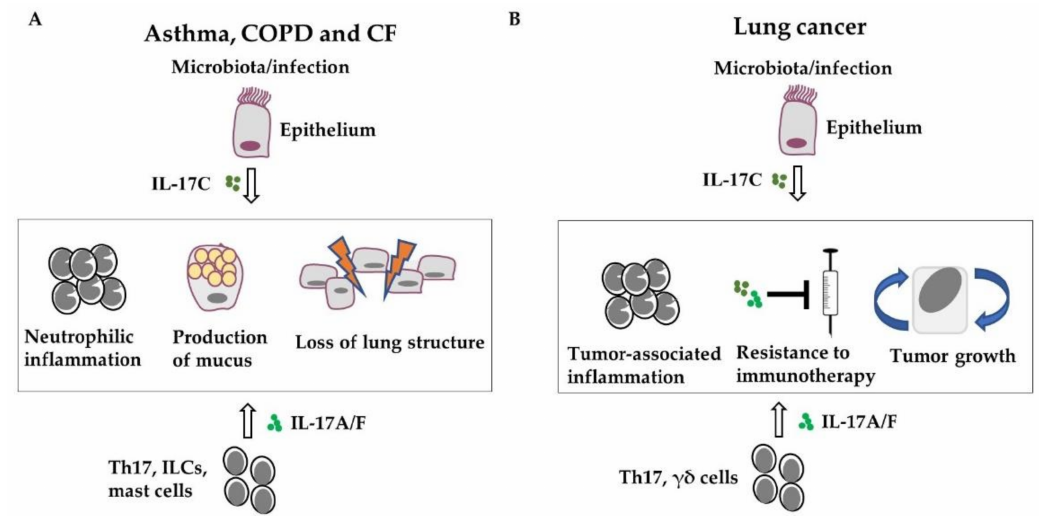
Figure 2. IL-17 cytokines promote the progression of chronic lung diseases. Acute and chronic infections or disease-associated microbiota drive the expression of IL-17 in immune and epithelial cells. IL-17-mediated expression of cytokines and recruitment of inflammatory cells, mainly neutrophils, result in airway remodeling (e.g., goblet cell hyperplasia) and lung damage in COPD, CF, and asthma ( A ) as well as in tumor proliferation and resistance to immunotherapy in lung cancer ( B